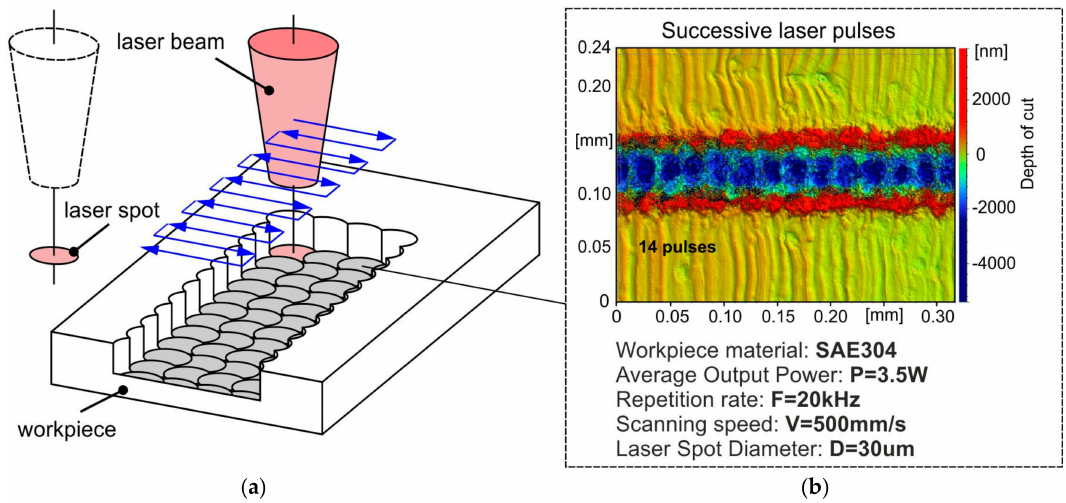
Figure 1. Laser engraving process ( a ) Schematic illustration of the laser engraving process; and ( b ) engraving depth of 14 successive laser beam pulses in a SAE304 stainless steel